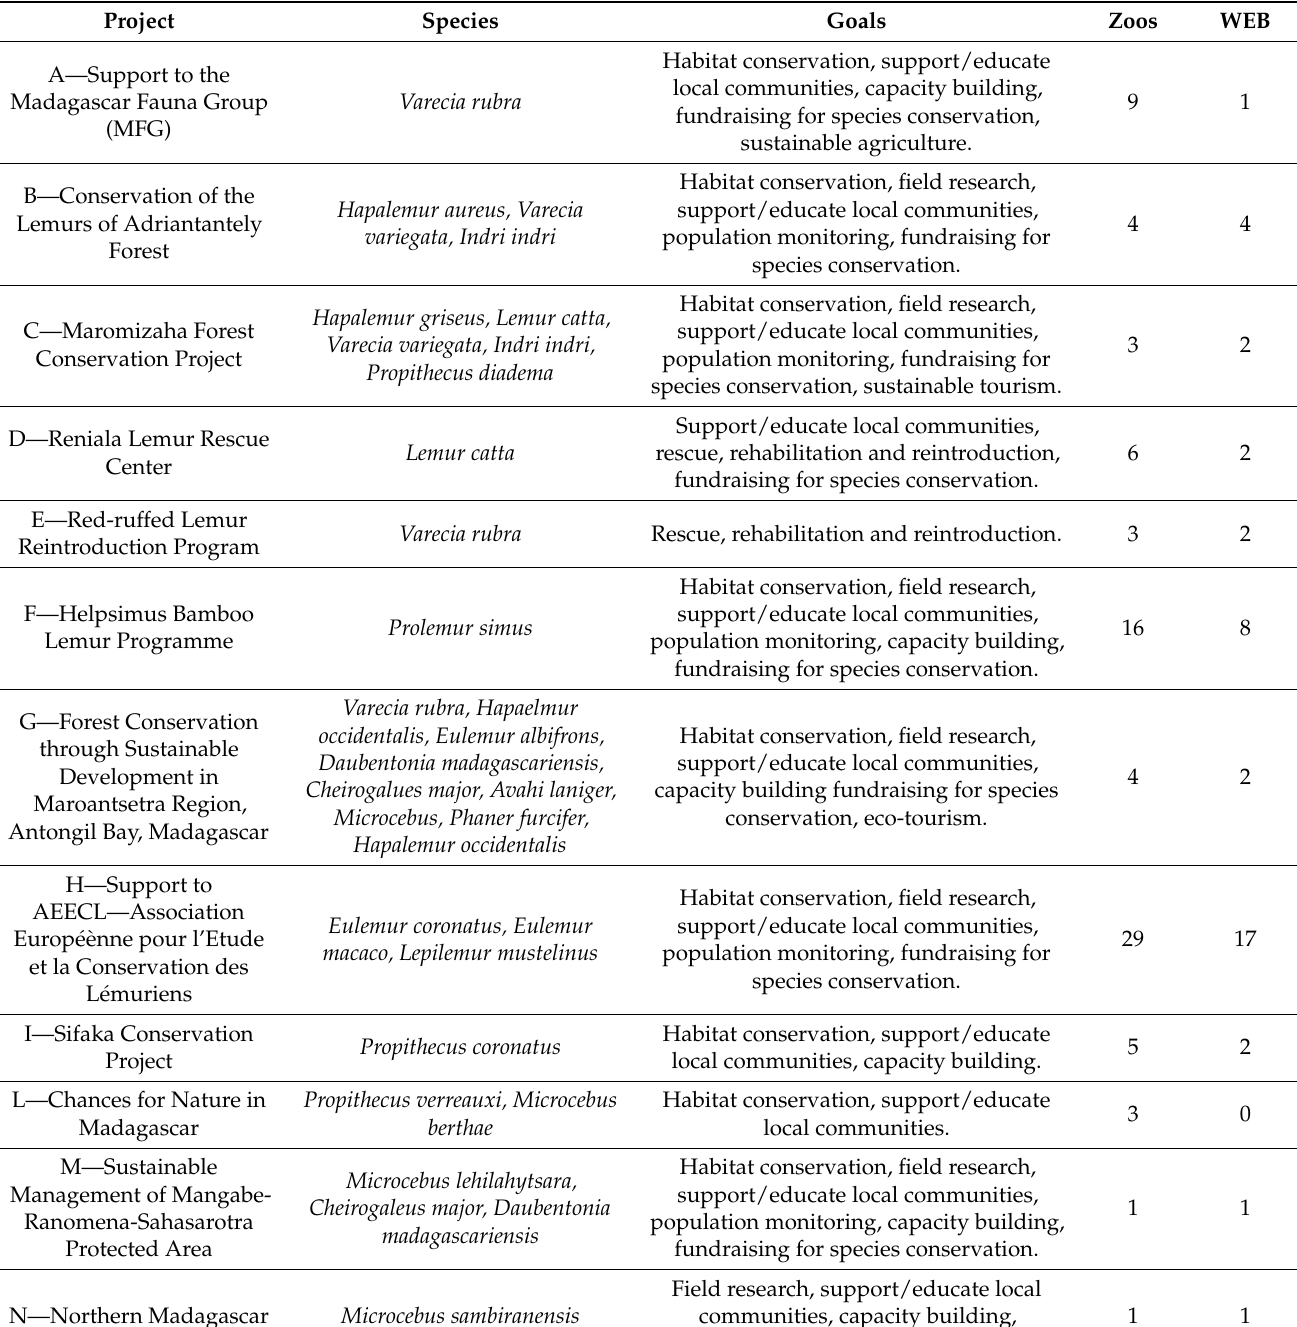
Table 1. Twelve lemur conservation projects used in the study. For each project the table reports name, species involved, goals, number of zoos involved (Zoos), and number of webpages on websites of zoos involved